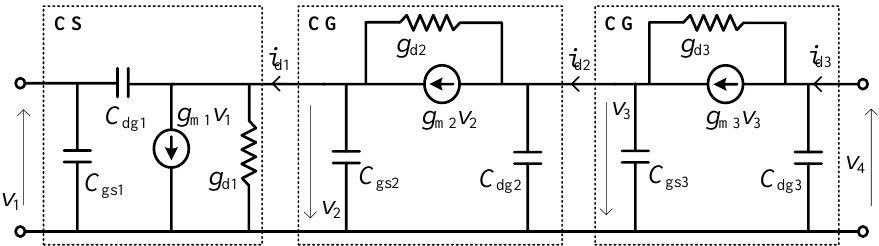
Figure 3. Small-signal equivalent circuit of the proposed 3-stack GaN high-electron-mobility transistor (HEMT)